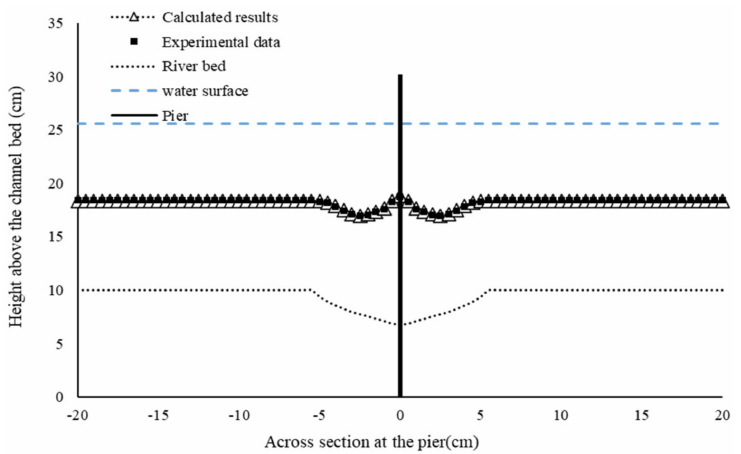
Figure 6. Transverse distribution of ice wave thickness at the cross section where the pier is